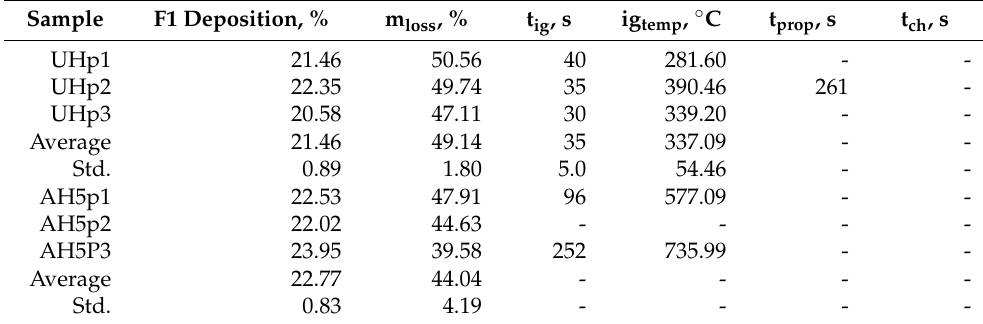
Table 5. Ignition parameters for UHp and